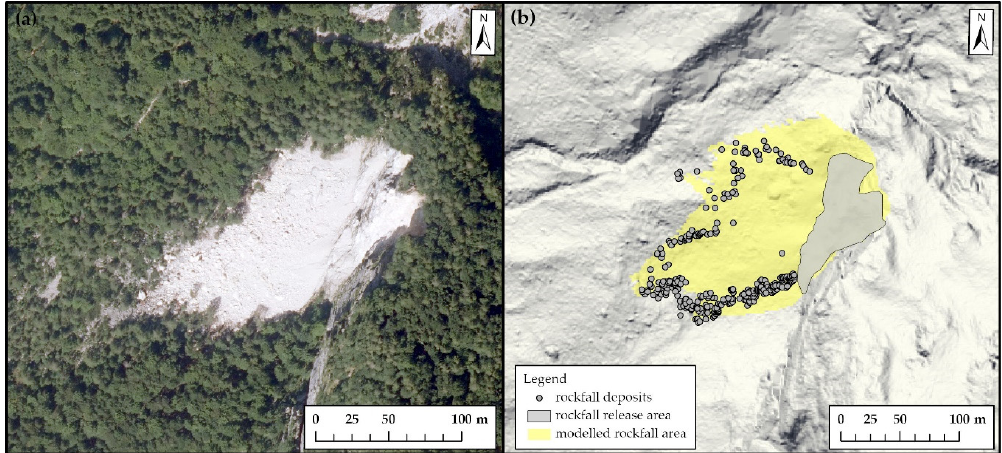
Figure 12. ( a ) Orthophoto image of the Trenta rockfall and ( b ) results of rockfall modelling with Rockyfor3D model with marked locations of outline rockfall deposits.